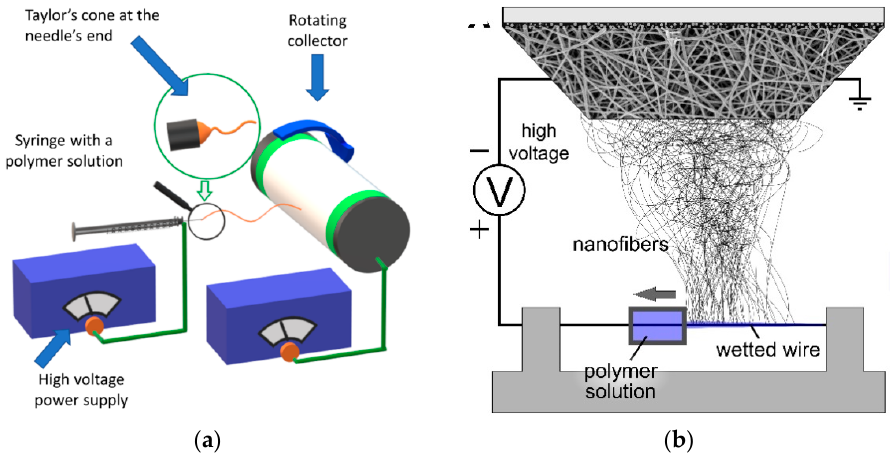
Figure 3. Electrospinning techniques: ( a ) Needle-based electrospinning. From [51], originally pub- lished under a CC-BY license; ( b ) wire-based electrospinning. From [52], originally published under a CC-BY